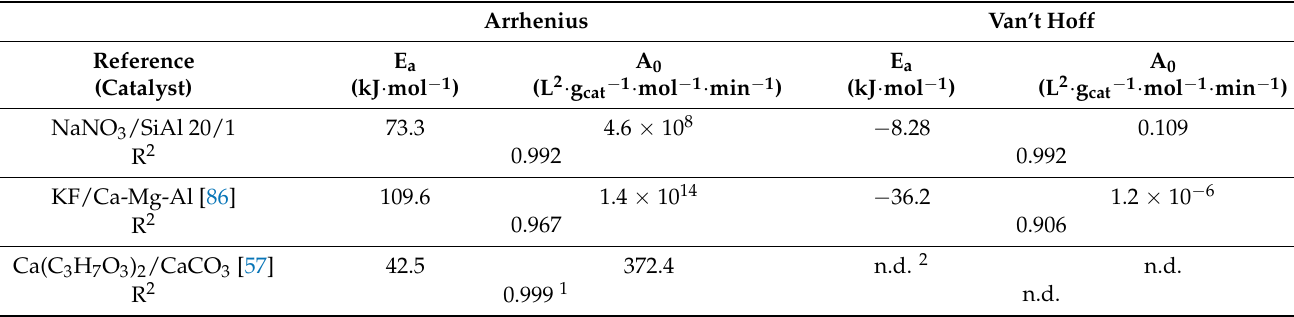
Table 8. Activation energy and methanol adsorption heat through the adjustment to Arrhenius and Van’t Hoff equations. Comparison with the literature.